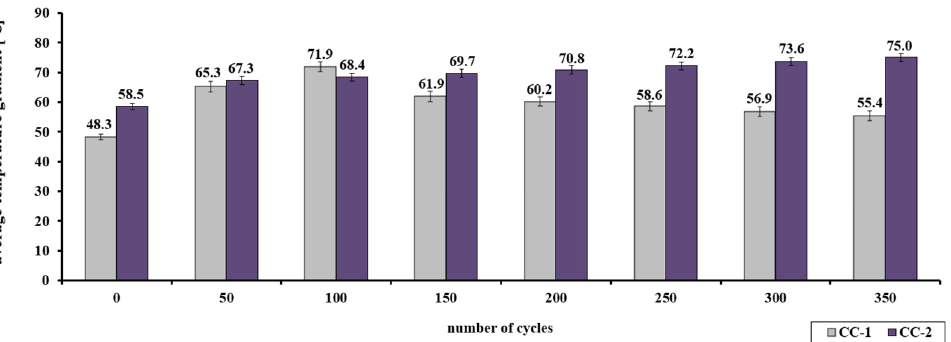
pressive strength of concrete CC-1 and CC-2—scheme B.